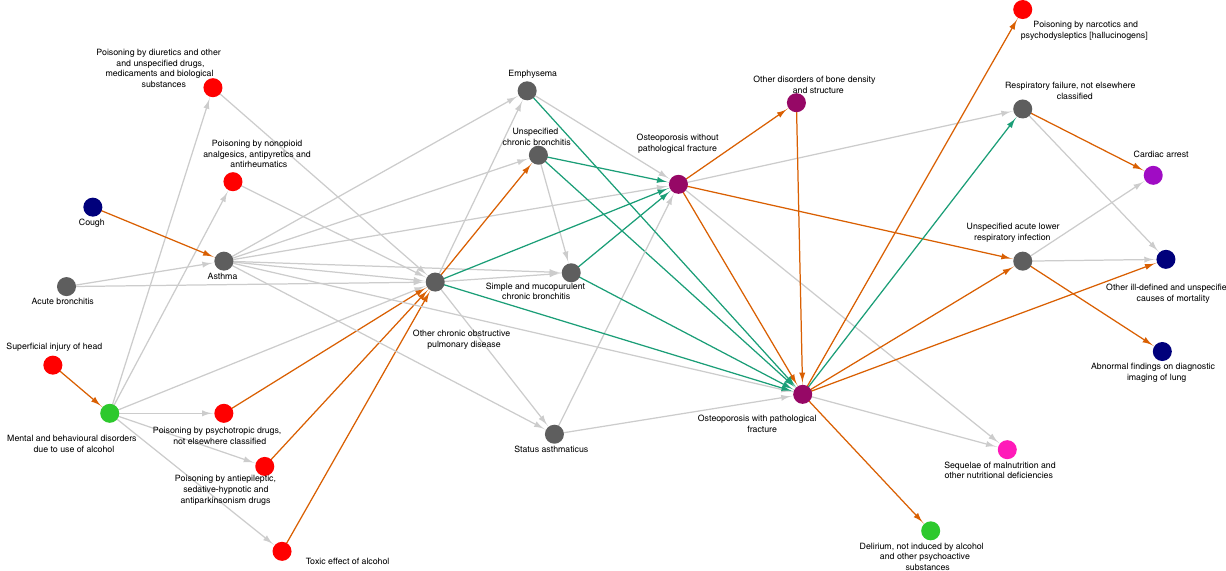
Fig. 7 Diagnosis trajectories related to obstructive lung disease and osteoporosis. A trajectory network combining 112 linear diagnosis trajectories including osteoporosis (M80, M81) and obstructive lung diseases (J40 − J46). The orange edges indicate co-occurrences only present in women, and the green edges indicate co-occurrences only present in men. The trajectories illustrate how obstructive lung diseases are found as a risk factor for osteoporosis in men, but not women. Moreover, osteoporosis without fracture followed by osteoporosis with fracture was only found in